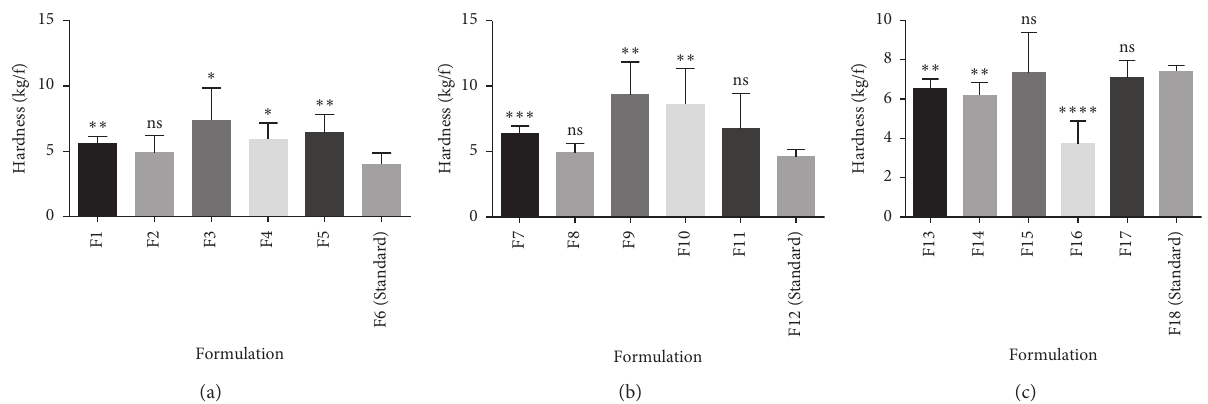
Figure 4: Comparative analysis on the crushing strength of pectin from various genotypes as disintegrants ((a) 5% w/w, (b) 7.5% w/w, and (c) 10% w/w) and a standard disintegrant using t -test. Values are mean ± SD ( n � 6). ∗ p ≤ 0 . 05, ∗∗ p ≤ 0 . 01, ∗∗∗ p ≤ 0 . 001, ∗∗∗∗ p ≤ 0 . 0001, and p > 0 . 05 not significant (ns).